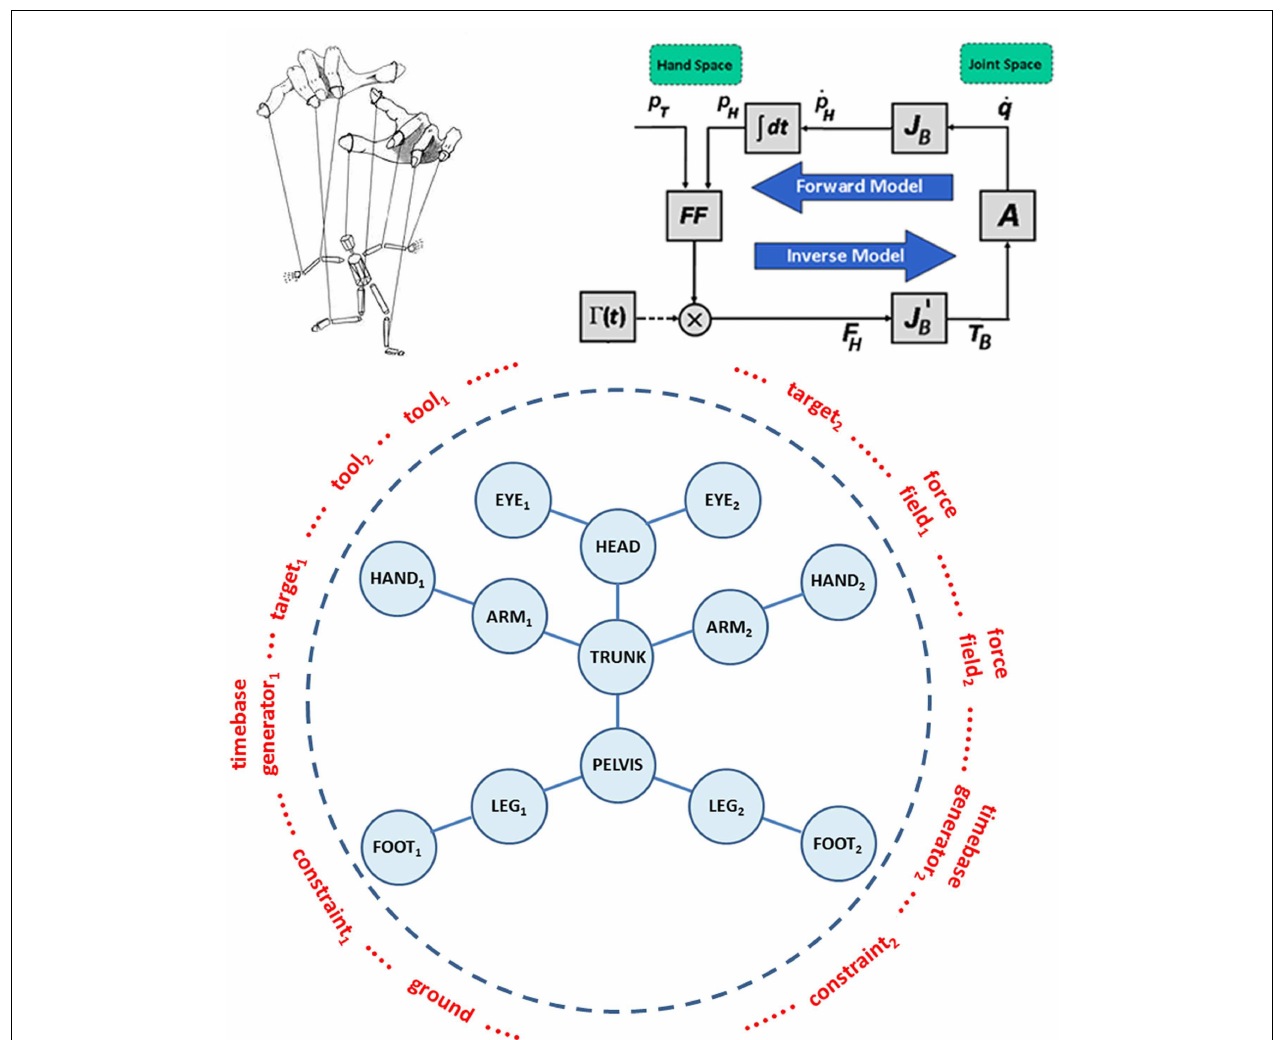
links the Hand and Joint spaces is represented by the Jacobian matrix of the body J B . Additional constraints, in the hand and joint spaces, can be represented by means of corresponding force or torque fields. Bottom panel : generalized representation of the whole-body schema within the PMP framework, to be configured in the preparation time of an action with a selection of tools , targets , time-base generators, ground , and specific task-oriented constraints